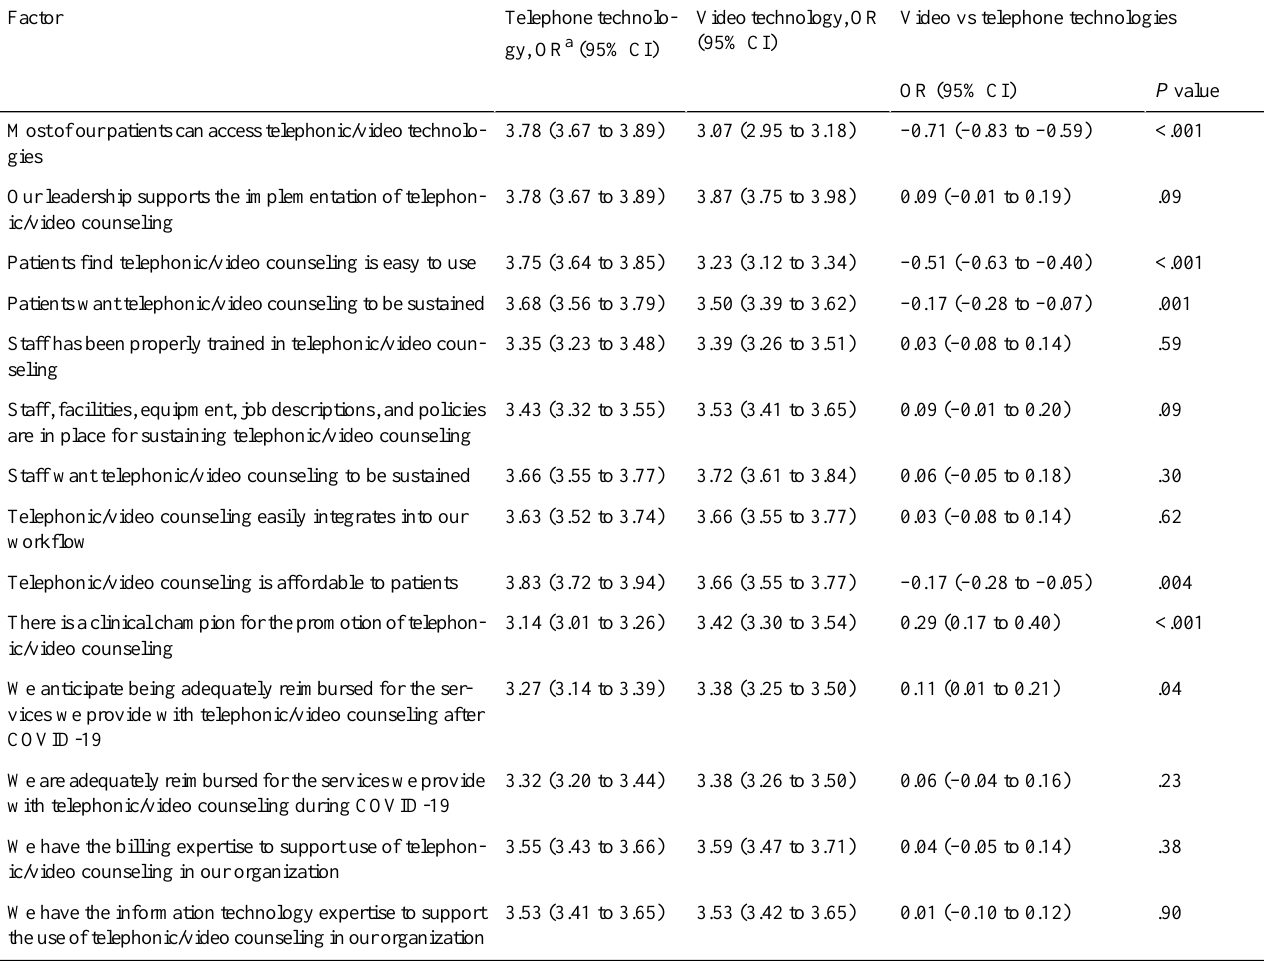
Table 3. Organizational readiness for using telephone and video technologies.